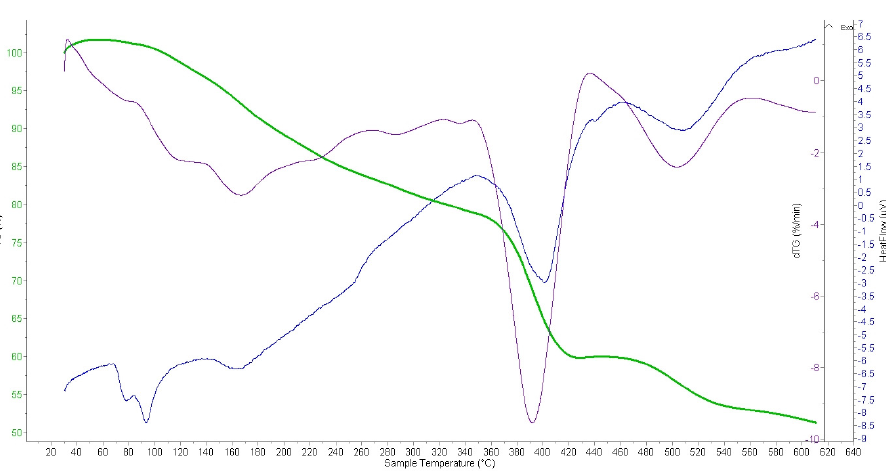
Figure 11. Thermogravimetric analysis (TGA) curves of europium nitrate. Comparative thermal destruction of initial Amberlite IR120 (without sorbed eu- ropium), individual Amberlite IR120 and Amberlite IR120 from the interpolymer pair Amberlite IR120:AB-17-8 = 1:5 (macromolecular structures are taken 1.5 h from the time of interaction due to the fact that difference of the sorption parameters is maximum at this time in accordance with Tables 4–6) is presented on Figure 12. Figure 13 represents comparison of thermal destruction curves (mass loss (a) and rate of mass loss (b)) of individual Amberlite IR120, Amberlite IR120 from ratio 6:0